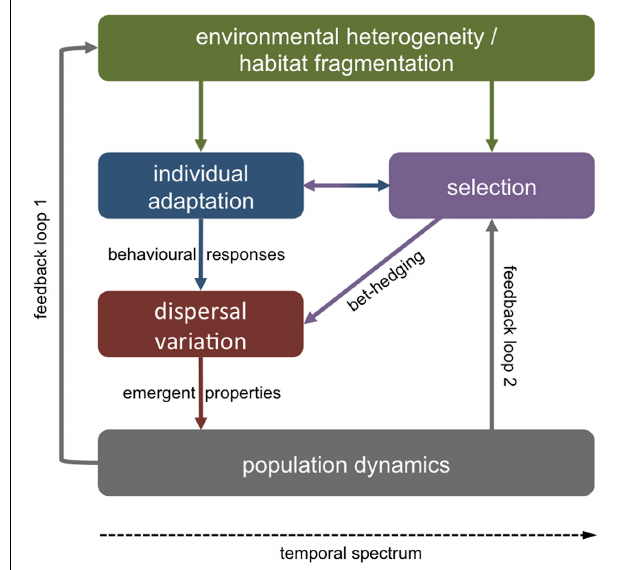
FIGURE 1 | Sources of adaptive dispersal variation. Variable dispersal strategies may present an evolutionary adaptation to stochastic and unpredictable environments. In such cases, parents may produce offspring with variable phenotypes that vary in their dispersal tendency and/or ability. On shorter temporal scales, individuals may adapt to ambient extrinsic factors (e.g., food availability) via behavioral responses (e.g., vertical migration) with vital effects on dispersal pathways. In either case, variation in dispersal on the individual level shapes emergent properties of population-level dynamics. In turn, individual dispersal strategies (i.e., philopatry, short, or long distance dispersal) affect the spatial environmental variability that a population will encounter (feedback loop 1). Emergent metapopulation dynamics (e.g., gene flow) feedback to selection on phenotypes in heterogeneous environments (loop